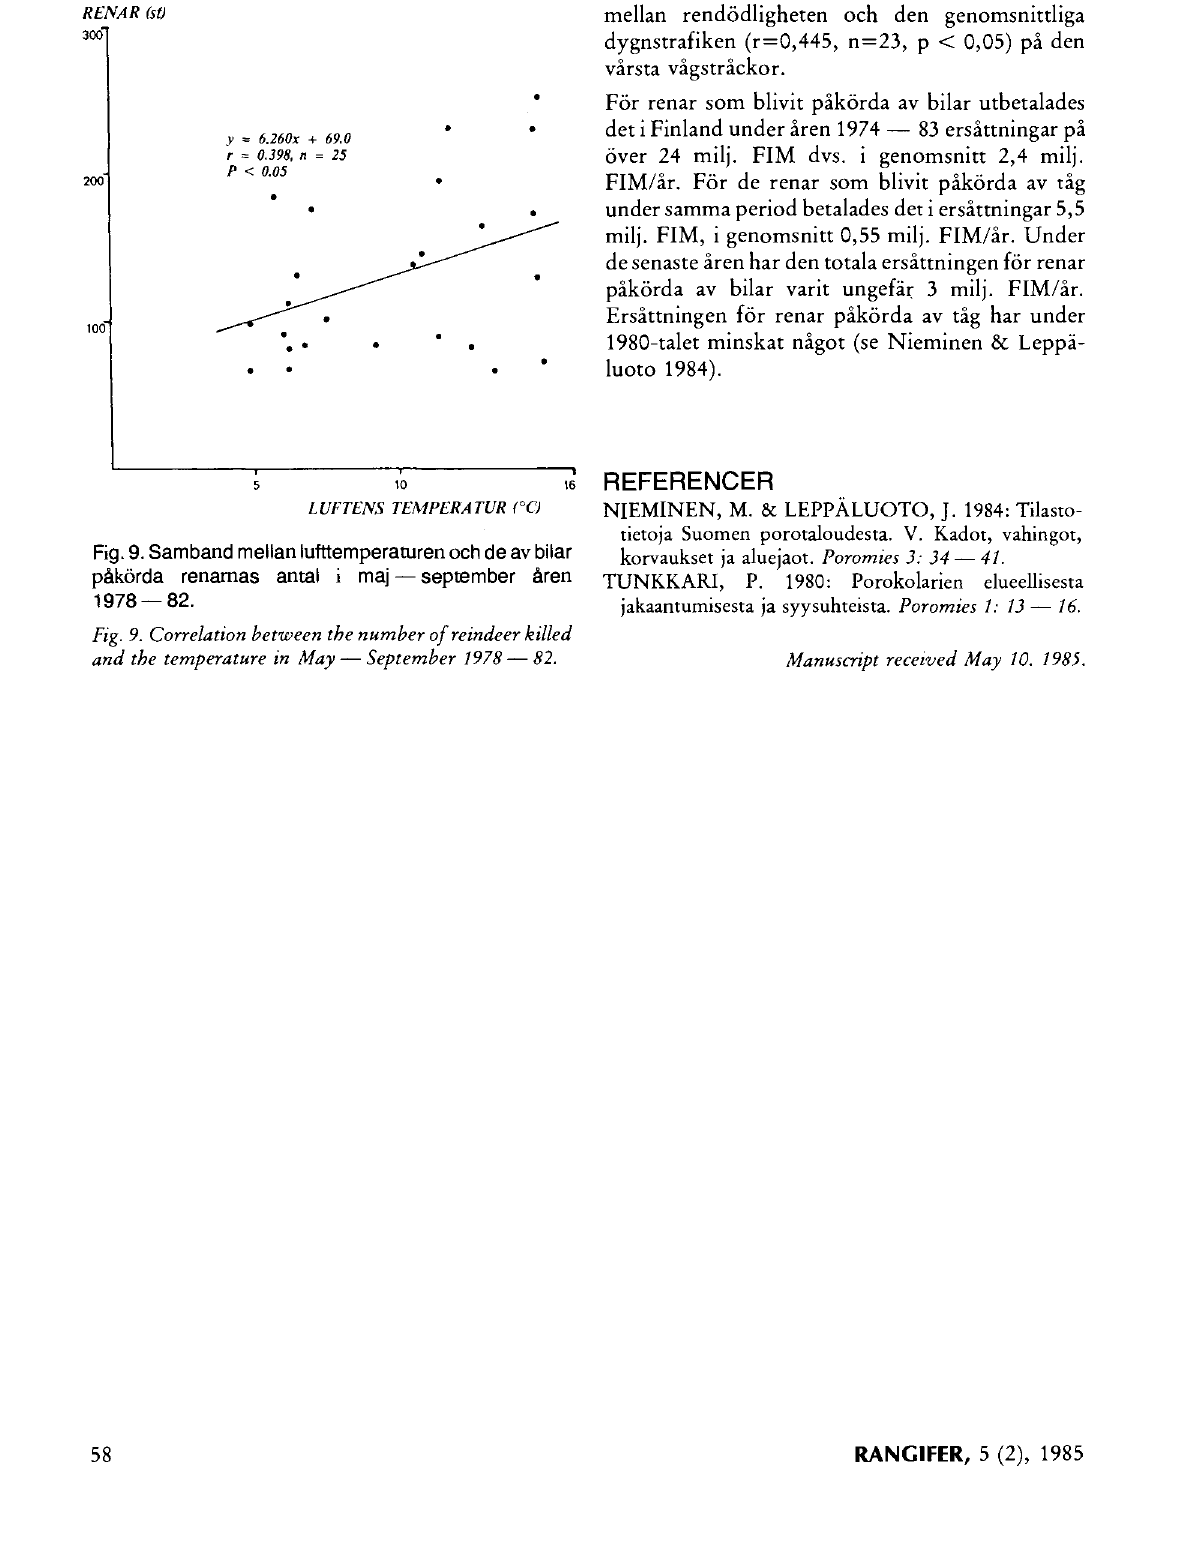
Fig. 9. Samband mellan lufttemperaturen och de av bilar påkorda renarnas antal i maj — september åren 1978 — 82. Fig. 9. Correlation between the number of reindeer killed and the temperature in May — September 1978 — 82.